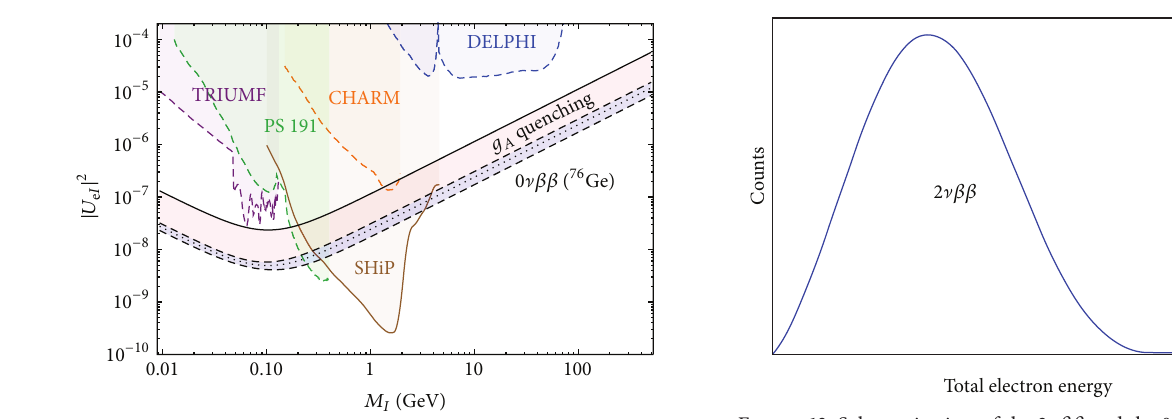
Figure 12: Bounds on the mixing between the electron neutrino and a single heavy neutrino from the combination of bounds obtained with Ge 0 ] 𝛽𝛽 experiments [77] using the representation introduced in [191]. The bands correspond to the uncertainties discussed in the text. The dashed contours indicate the mass regions excludedbysomeoftheacceleratorexperimentsconsideredin[105]: CHARM (90% CL, [192]), DELPHI (95% CL, [193]), PS 191 (90% CL, [194]), and TRIUMF (90% CL, [195, 196]). The continuous contour indicates the expected probed region by the new proposed SHiP experiment at the CERN SPS [118]. Figure from [118].